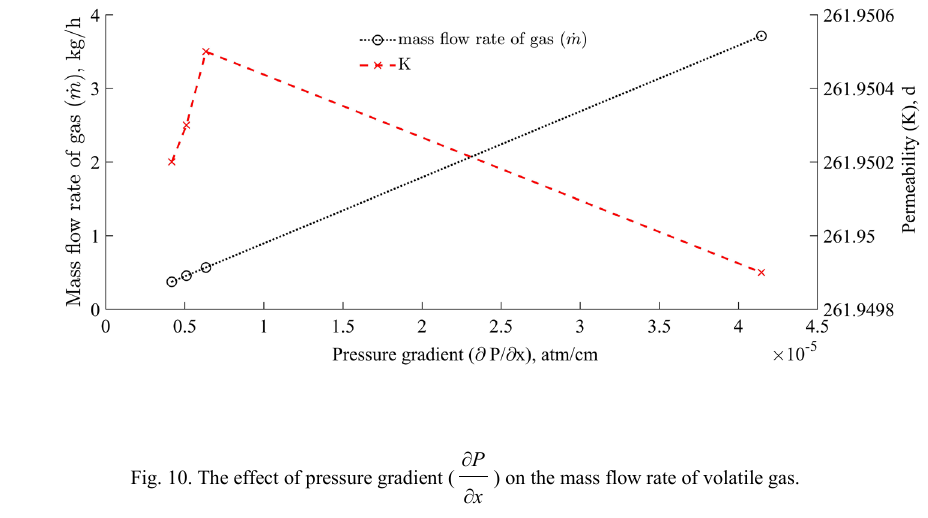
Fig. 10. The effect of pressure gradient (